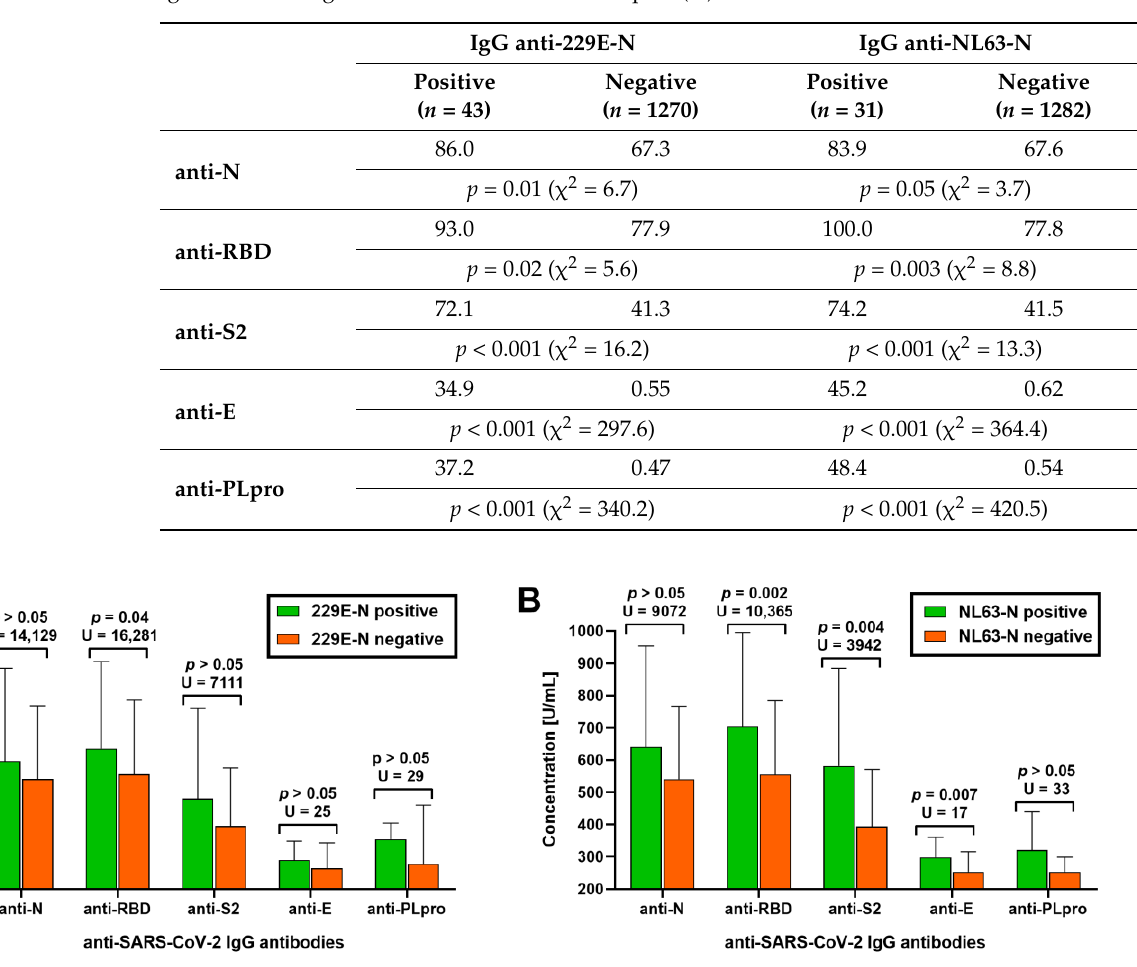
Figure 1. Serum titers of IgG antibodies against SARS-CoV-2 nucleocapsid (anti-N), a receptor-binding domain of spike protein (anti-RBD), subunit S2 of spike protein (anti-S2), an envelope protein (anti-E), and papain-like protease (anti-PLpro) in individuals seropositive and seronegative to ( A ) alphacoronavirus 229E and ( B ) NL63.